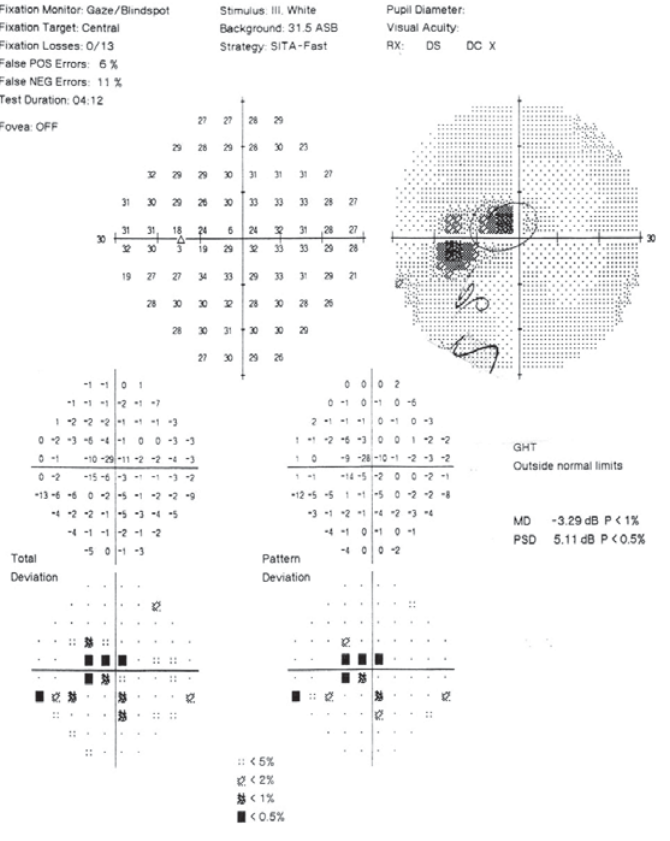
FIGURE 1. Centrocoecal scotoma on the right eye and central scotoma on the left eye